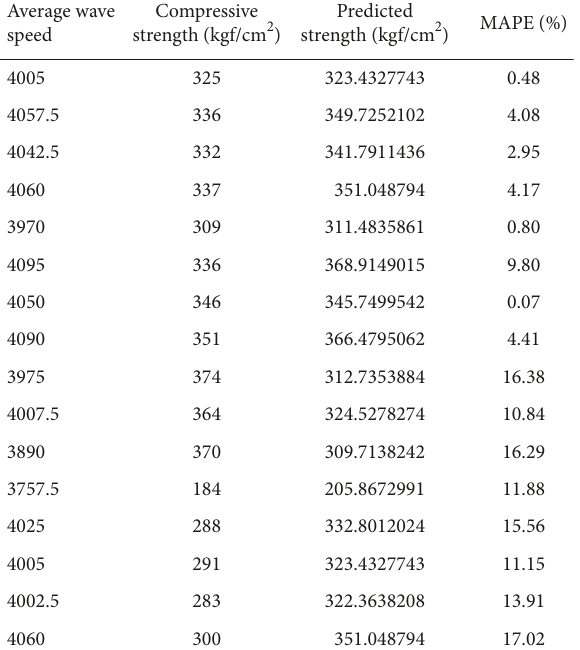
Figure 8: Predictor of absolute error percentage in inverted transmitter